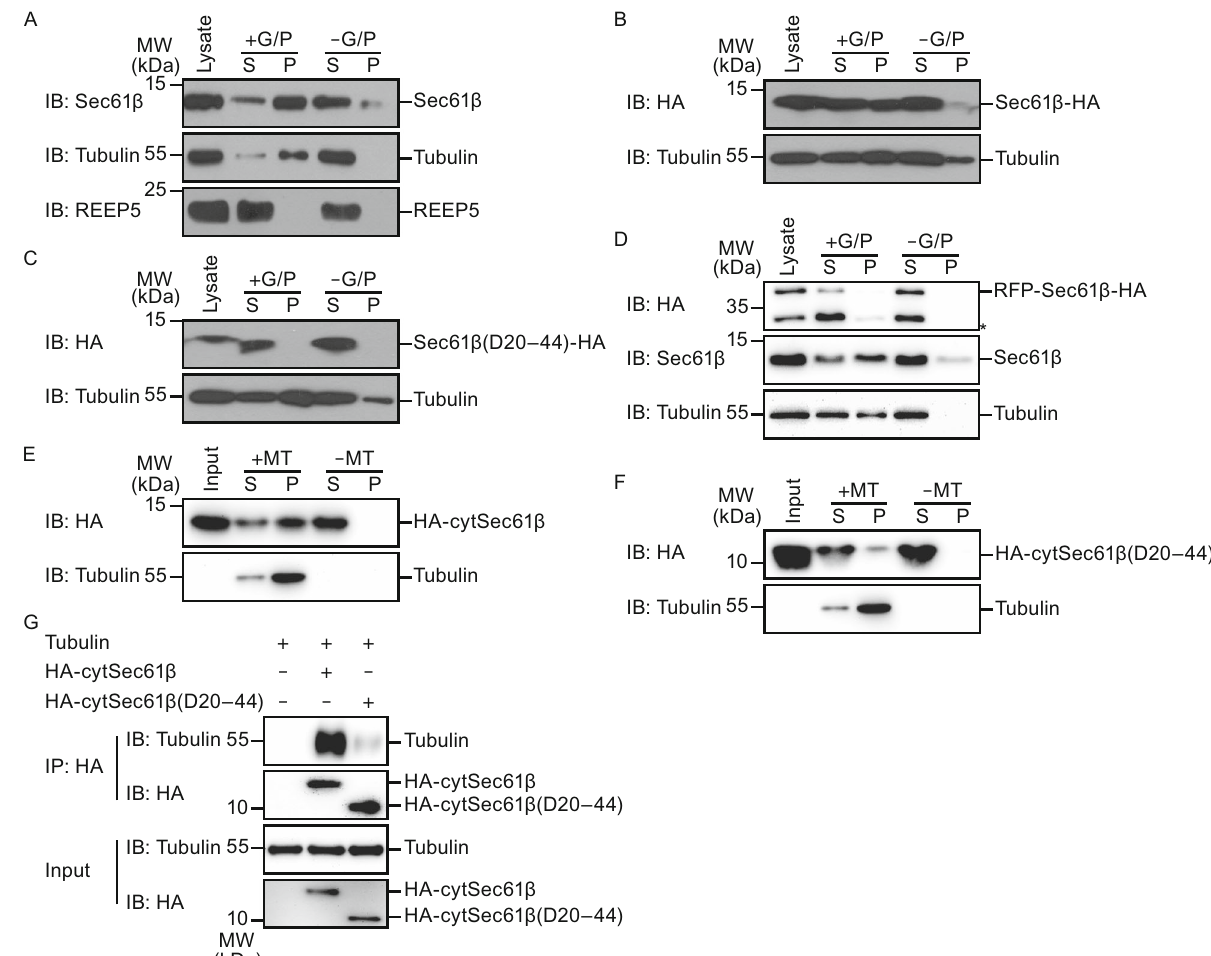
Figure 2. Sec61 β interacts with microtubule. (A) COS-7 cells were harvested for microtubule co-sedimentation in the absence or presence of GTP/paclitaxel (G/P). Samples of the supernatant (S) and pellet (P) were analyzed by Western blotting. (B – D) As in (A), but transfected with full length Sec61 β (B), Sec61 β lacking residues 20 – 44 (C) or RFP-tagged Sec61 β (D). The bands with asterisk (*) may be degraded RFP-Sec61 β -HA. (E) Puri fi ed wild-type HA-cytSec61 β was incubated with microtubules (MT) or not, for microtubule co-sedimentation. Samples were analyzed by Western blotting. (F) As in (E), but with HA-cytSec61 β lacking residues 20 – 44. (G) Puri fi ed wild-type HA cytSec61 β or HA-cytSec61 β lacking residues 20 – 44 was incubated with tubulins and precipitated with anti-HA antibody. The levels of indicated proteins were analyzed with Western